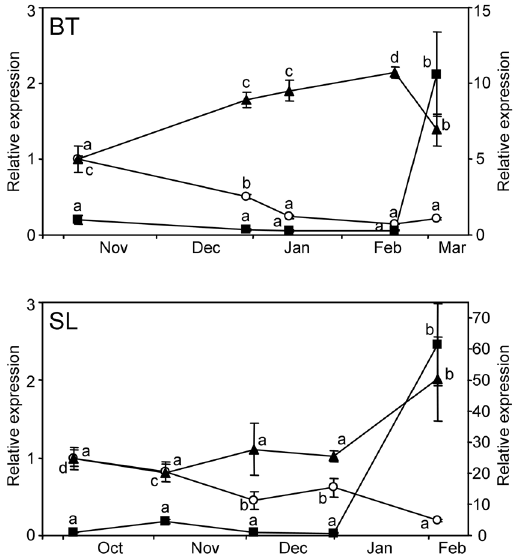
Figure 10. Expression of TOR -like and TIP -like genes in reproductive buds of peach. The relative expression of PpSAP1 (white circles, left y-axis), TOR -like (black triangles, left y-axis) and TIP -like genes (black squares, right y-axis) was measured along bud development in cultivars ‘Big Top’ (BT) and ‘Springlady’ (SL). Dormancy was released in March (BT) and February samples (SL). An expression value of one is assigned to the first sample. Data are means from two biological samples with three technical replicates each, with error bars representing standard deviation. Different letters ( a – d ) indicate significant difference between samples for each gene, at a confidence level of 95%.